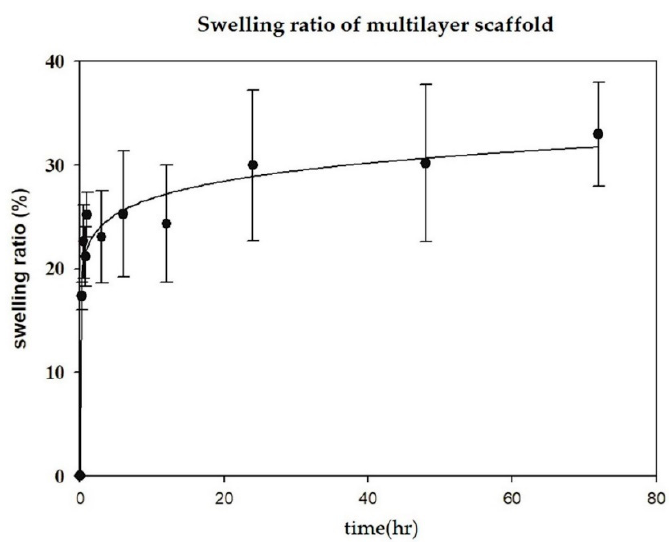
Figure 4. Swelling property of fibroin/gelatin electrospun implant. ( n = 5).